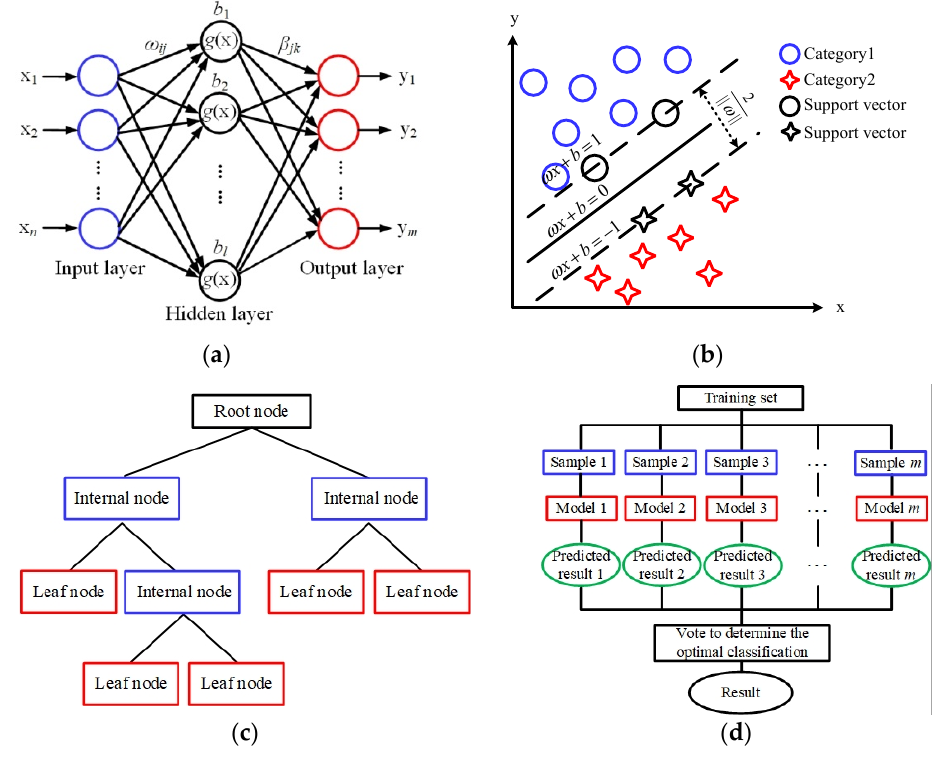
Figure 2. Classification models. ( a ) ELM; ( b ) SVM; ( c ) decision tree; ( d )